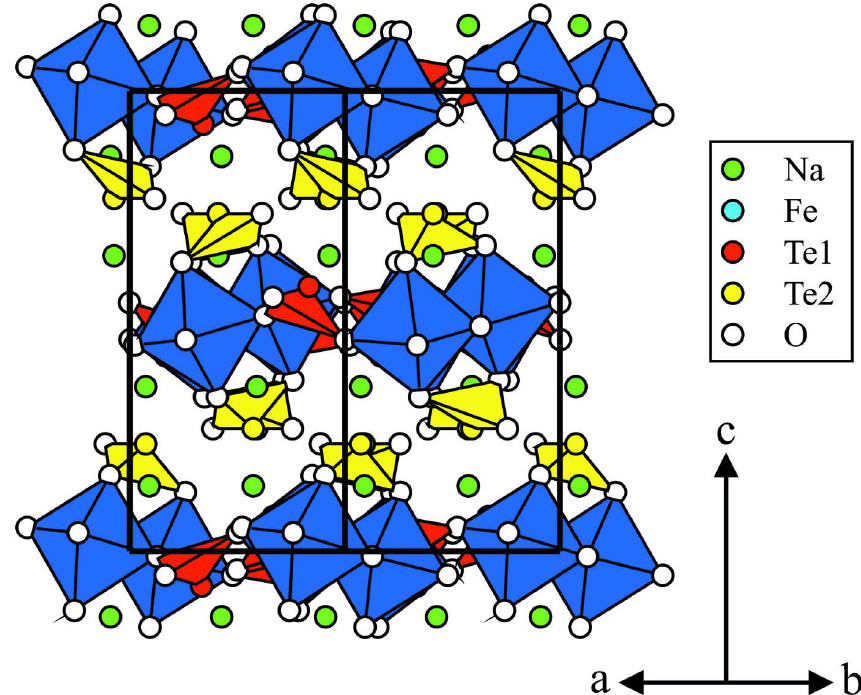
Figure 1 The crystal structure of NaGa(TeO